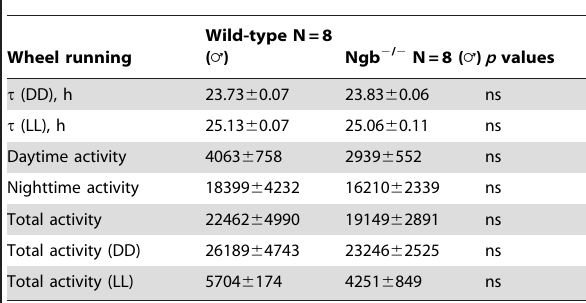
Table 1. Summary of activity